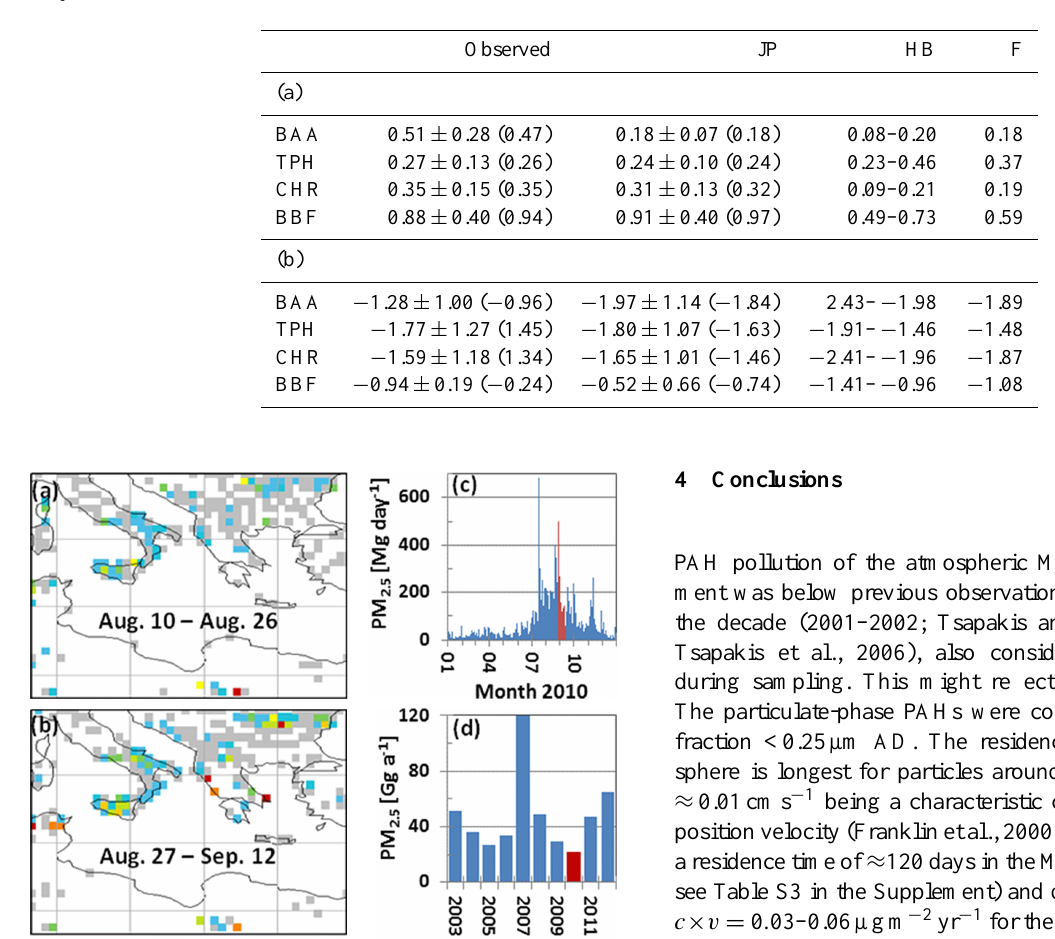
Table 3. Gas–particle partitioning of selected PAHs (mean ± SD (median)), observed and predicted by the models Junge–Pankow (1987) (JP), Harner and Bidleman (1998) (HB) and Finizio et al. (1997) (F), expressed as (a) particulate mass fraction, θ , and (b) log K p of this study.